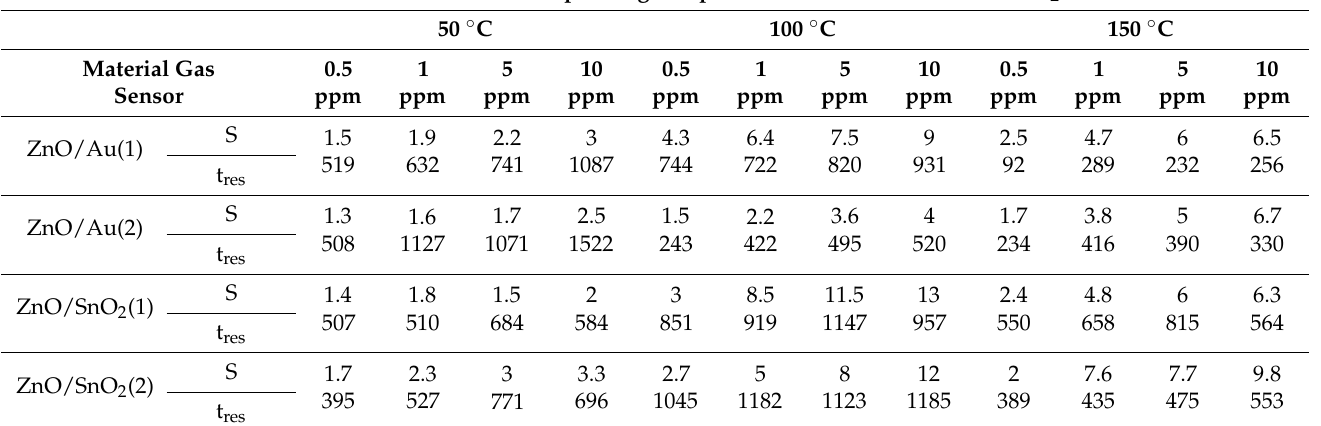
Table 1. Chemiresistive response magnitude, S, and response time, t res , characterizing sensors based on ZnO/Au and ZnO/SnO 2 NRs exposed to NO 2 under combined conditions of heating and UV -viz